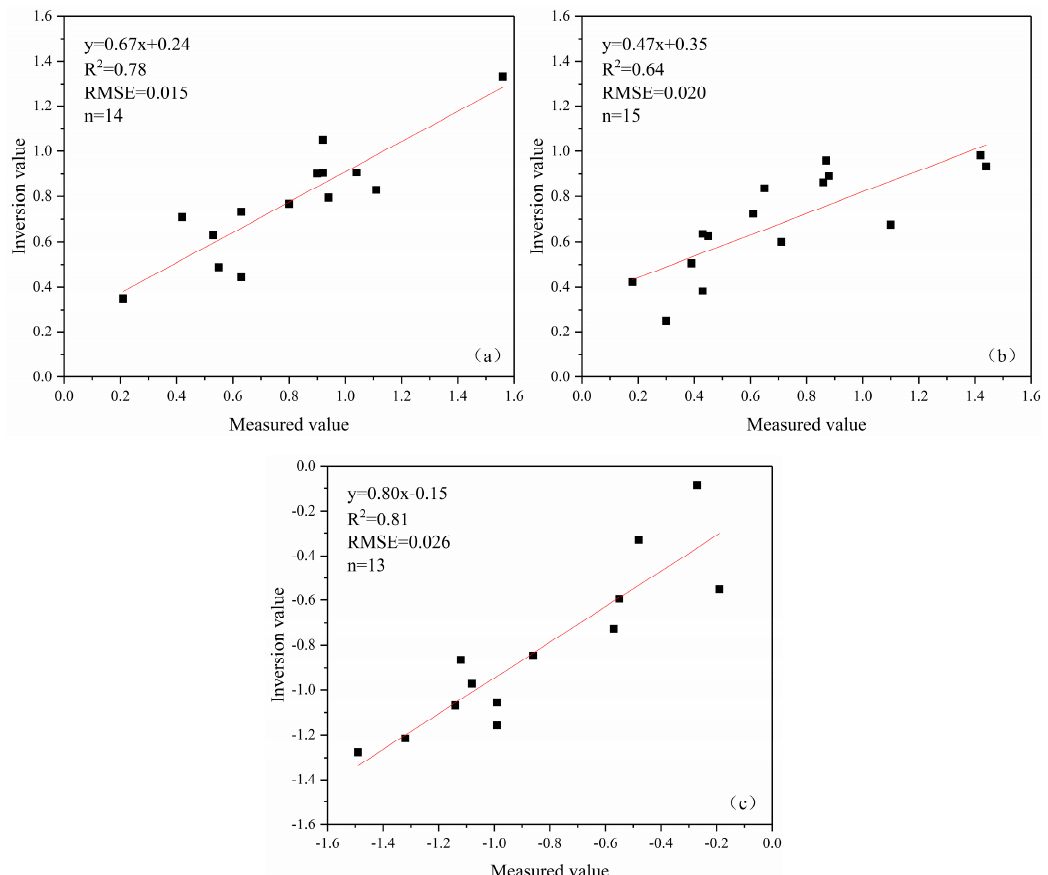
Figure 7. Scatter plots of the inverted and measured values of the west branch of No. 1 Glacier in the east ( a ), north ( b ) and vertical ( c ) directions (unit: m).